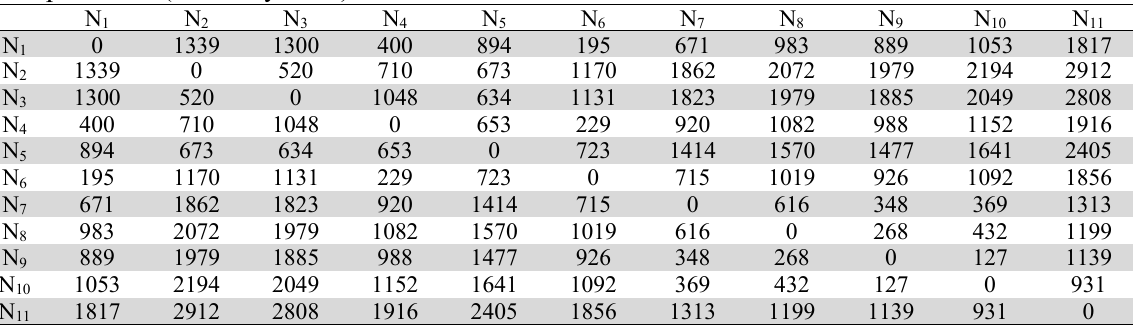
Transport costs (monetary units)